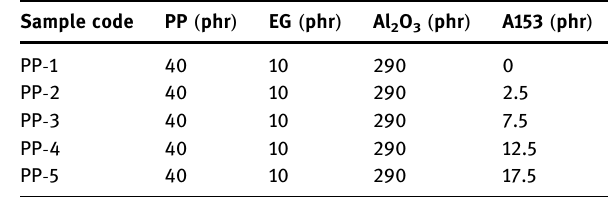
Table 2: Formula Sample